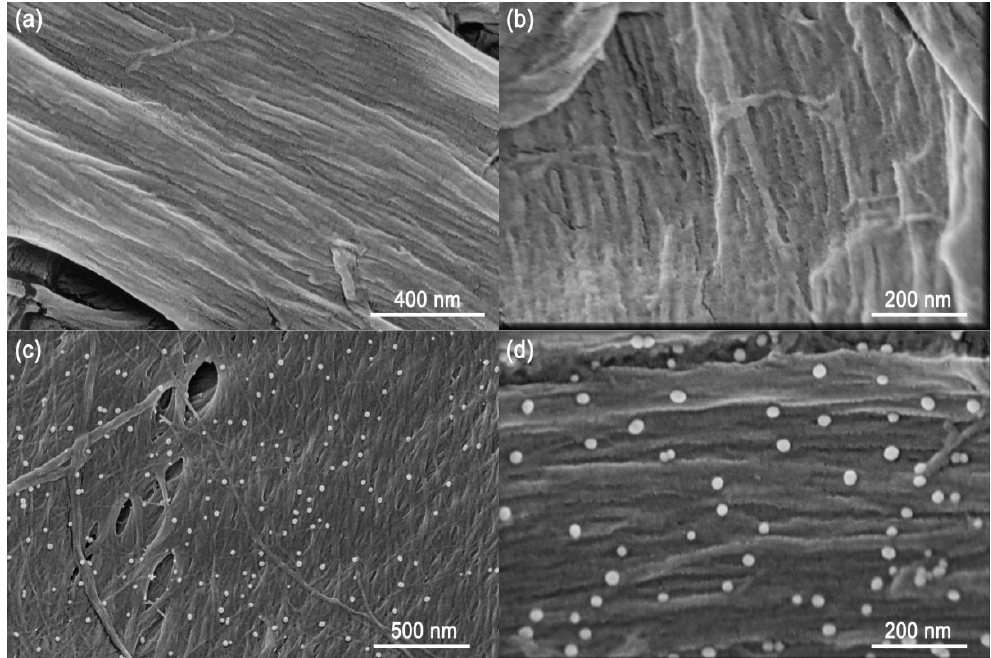
Figure 2. SEM images of original filter paper without AuNP solution immersion at ( a ) 100,000× and ( b ) 200,000× magnification, and AuNP-immersed filter paper at ( c ) 80,000× and ( d ) 200,000× magnification, and AuNP-immersed filter paper at ( c ) 80,000 × and ( d ) 200,000 × magnification, magnification, respectively.